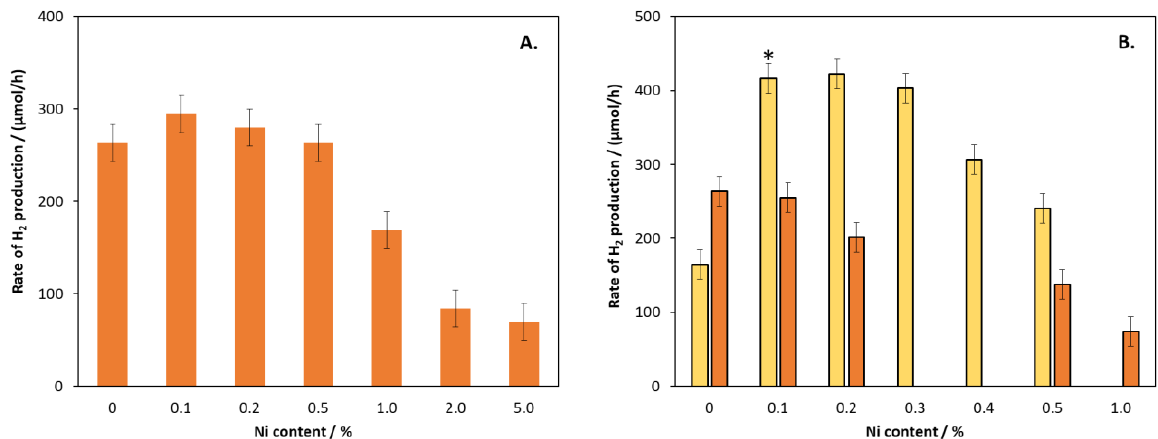
Figure 1. The rate of H 2 production for catalysts prepared from 2-fold excess of ammonia and modified with different amounts of Ni(II) in the bulk ( A ) and on the surface ( B ). Orange and yellow bars represent the hydrothermally treated and untreated catalysts, respectively. The asterix indicates the catalyst for which the quantum yield has been determined. The primary volume vs. time functions and their time derivatives (as rate of H 2 evolution) are given in the Supplementary Materials as Figure S1.